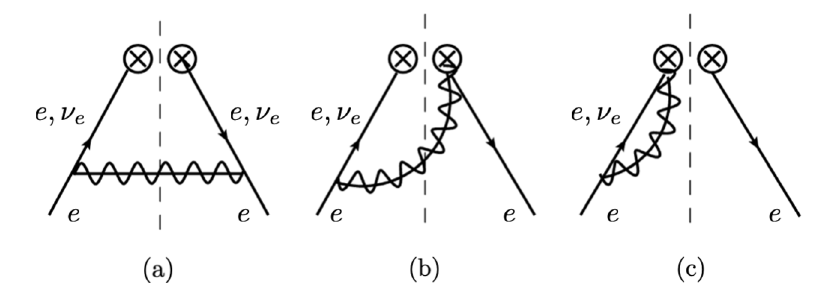
Figure 2 . Feynman diagrams for the beam function and the PDF at one loop. The mirror images of (b) and (c) are omitted. The wavy lines with solid lines denote collinear gauge bosons. The dashed lines denote the final cuts. For the beam function, the virtuality t and the longitudinal momentum fraction z are measured, while only the momentum fraction z is measured for the